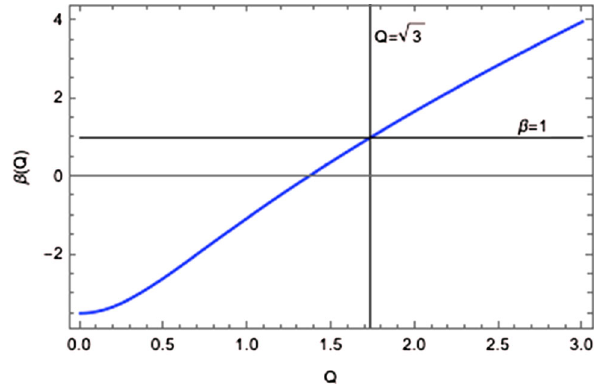
√ 3 yields √ 3 if considering β